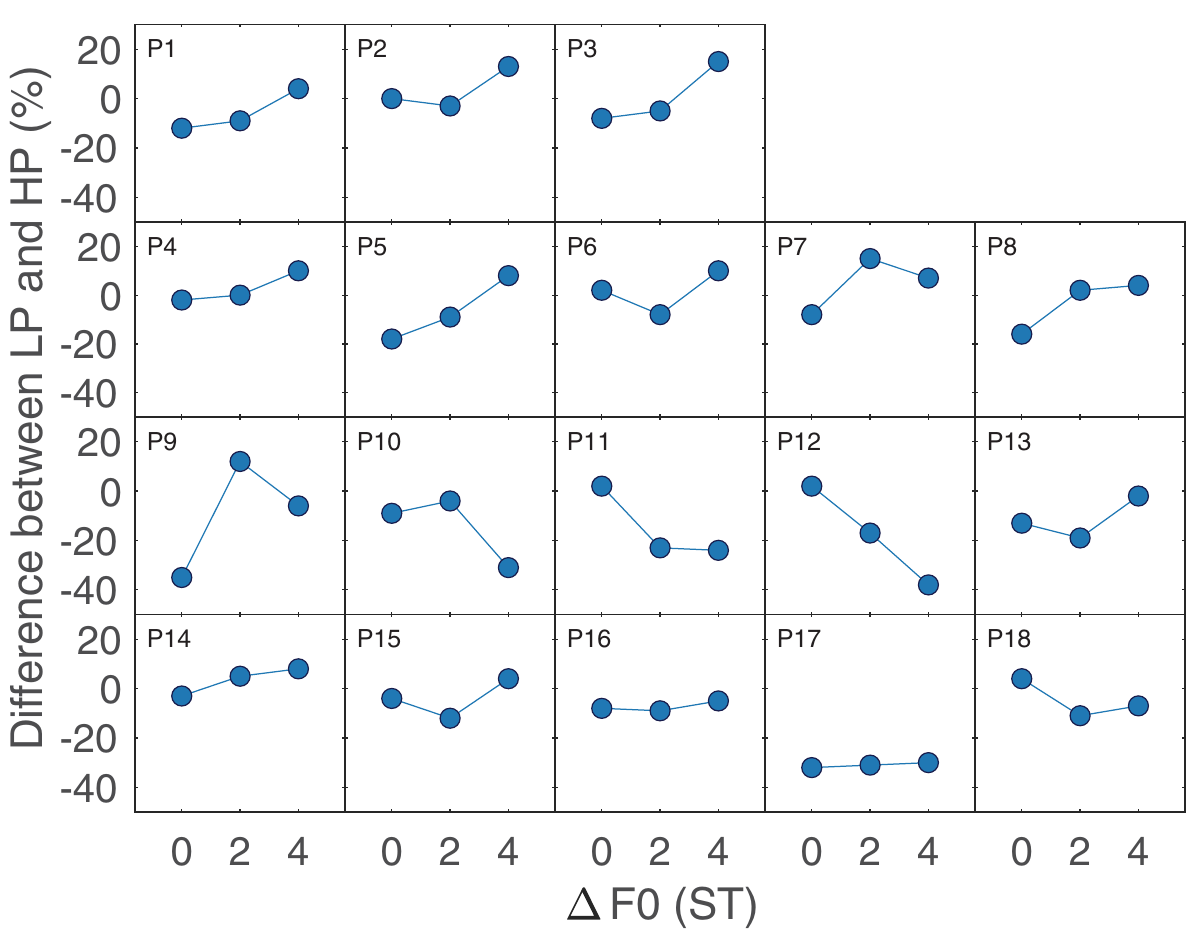
Fig 4. Difference between the lowpass-filtered and highpass-filtered conditions for each participant. A positive slope indicates a greater effect of Δ F0 for the LP-filtered than for the HP-filtered condition, as would be expected if greater pitch accuracy improved listeners’ ability to take advantage of average F0 differences between the target and